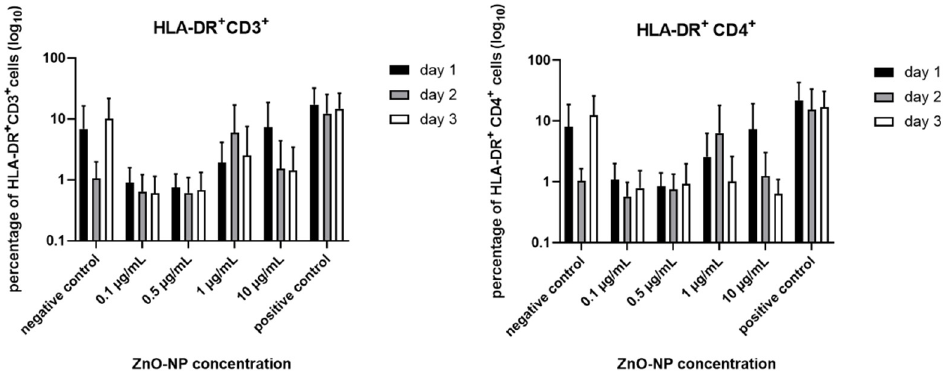
Figure 6. HLA-DR expression in the overall population and in the CD4 + subset. The expression declined independent of time in the samples treated with 0.1 and 0.5 µ g/mL ZnO-NP, and increased after incubation with 1 and 10 µ g/mL, especially on the first treatment day. Data represent the mean +/ − standard deviation (n = 9 for day 1, 2, and 3 for CD 3 + cells; n = 9 for day 1 and 2, n = 8 for day 3 for CD4 + cells). Table 2. Variation in CD4 + subpopulations after incubation with ZnO-NP in different concentra- tions for 24 h. None of the NP concentrations caused a statistically significant alteration compared to the negative control. Data represent the mean +/ − standard deviation (n = 9). Day 1